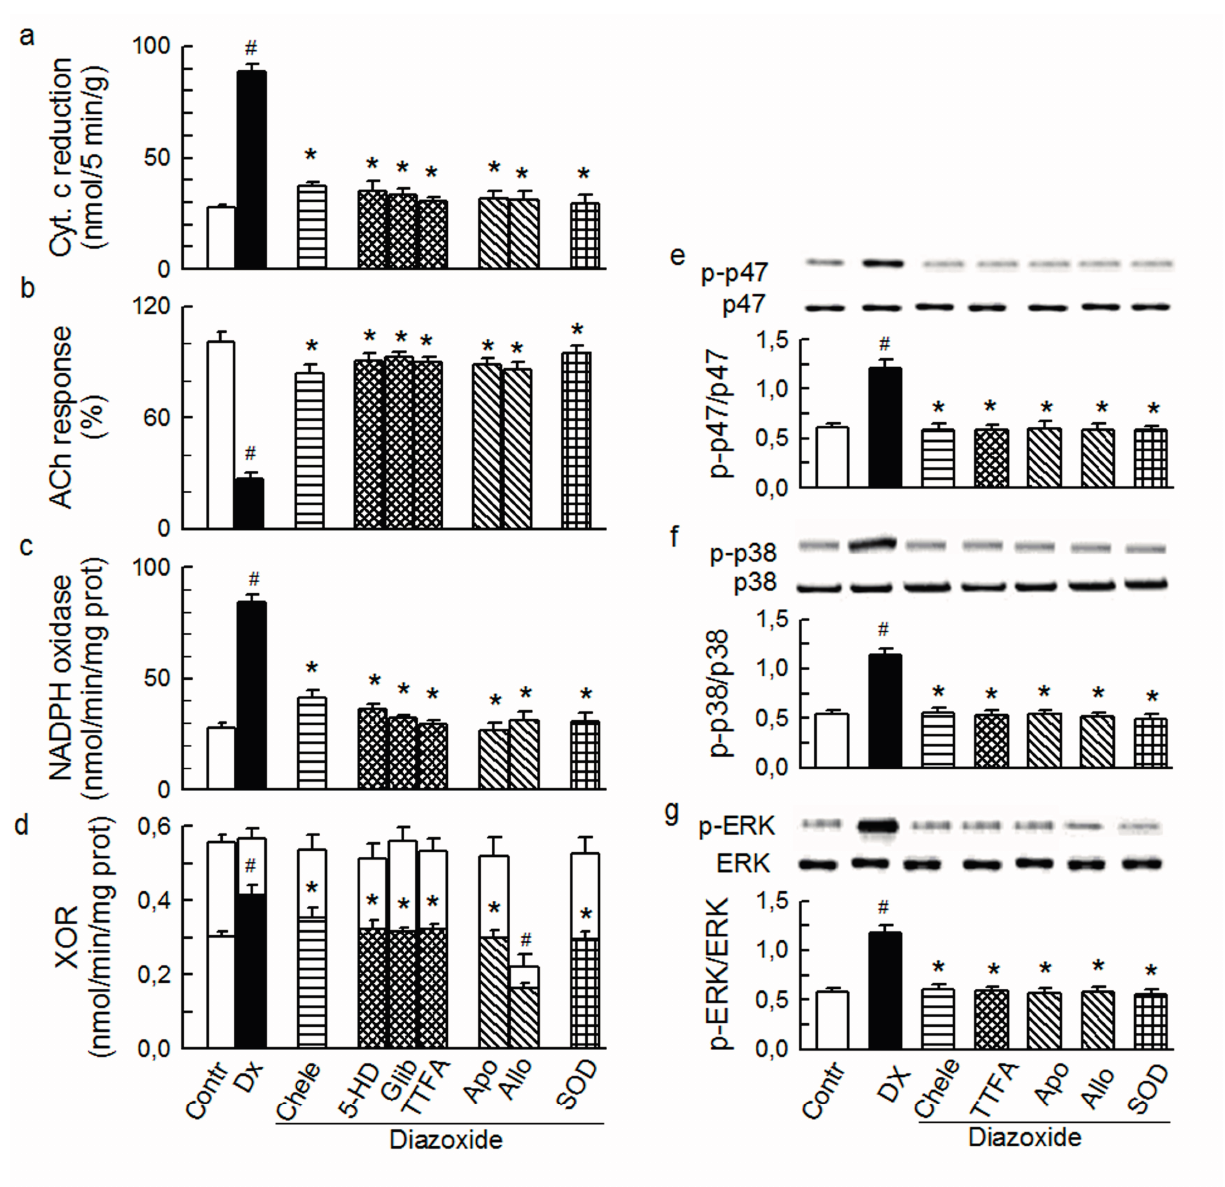
Figure 7. Effect of diazoxide (Dx, 2.5 μ M) on the total outflow of reduced cytochrome c ( a ); normalised acetylcholine (ACh) response ( b ); NADPH oxidase activity ( c ); xanthine oxidoreductase activity (XOR) ( d ); the phosphorylation of Ser345-p47phox ( e ), p38 ( f ) and ERK1/2 ( g ) in guinea-pig hearts. Diazoxide was administered either alone or in combination with (from left to right): 4 μ M chelerythrine (Chele), 100 μ M 5HD, 3 μ M glibenclamide (Glib), 5 μ M TTFA, 1 mM apocynin (Apo), 250 μ M allopurinol (Allo), and 150 IU/mL SOD. Values are means ± SEM of at least five experiments in a – d and of four experiments in e – g . # p < 0.05 vs. control; * p < 0.05 vs.